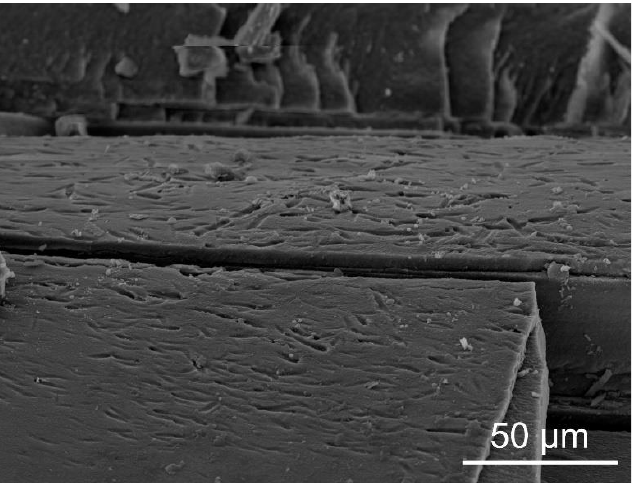
Figure 6. Cylindrical shafts in the lamella of Sphenothallus sp. from the Carboniferous of